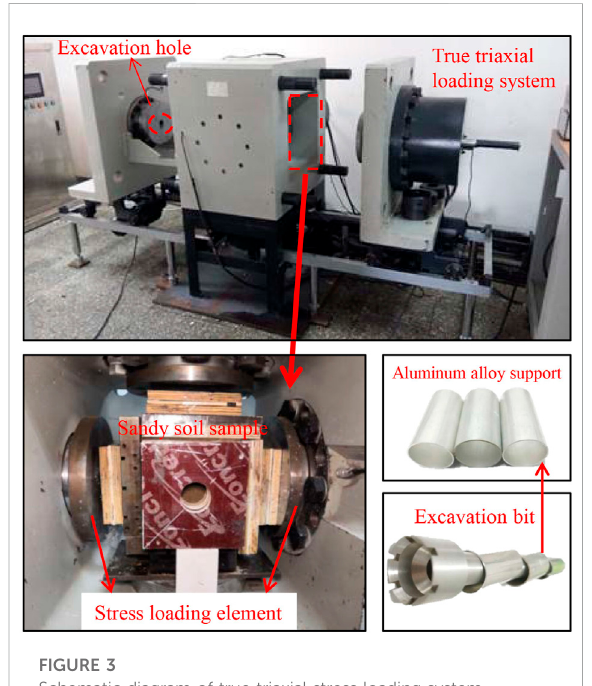
FIGURE 3 Schematic diagram of true triaxial stress loading